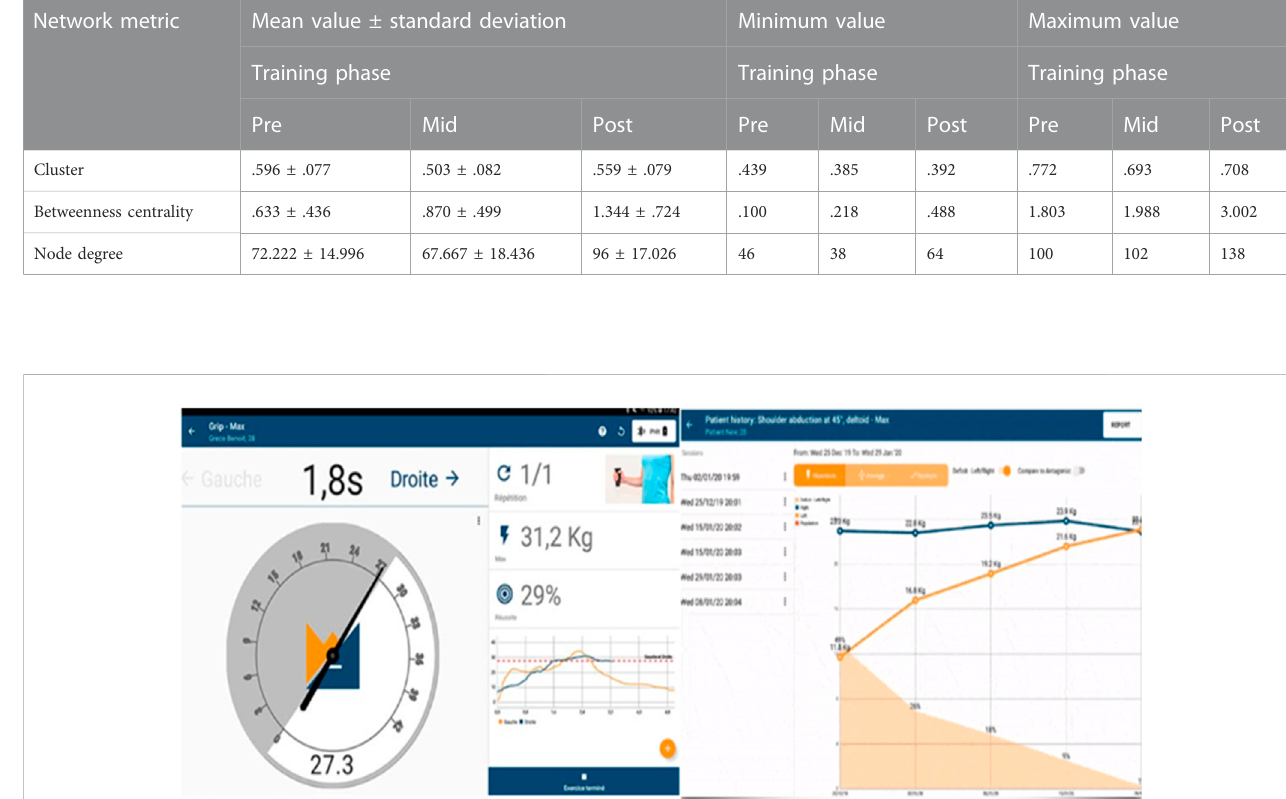
TABLE 3 Descriptive statistics for the right precentral gyrus, where “ pre ” stands for before SAHC, “ mid ” stands for SAHC alone in both protocols, and “ post ” stands for SAHC combined with exercise. Network metric